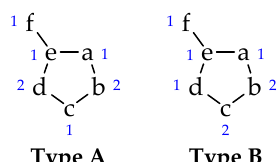
Figure 1. Type A and B of mesoionic structures. The numbers indicate the contribution of each atom to the π electron system.